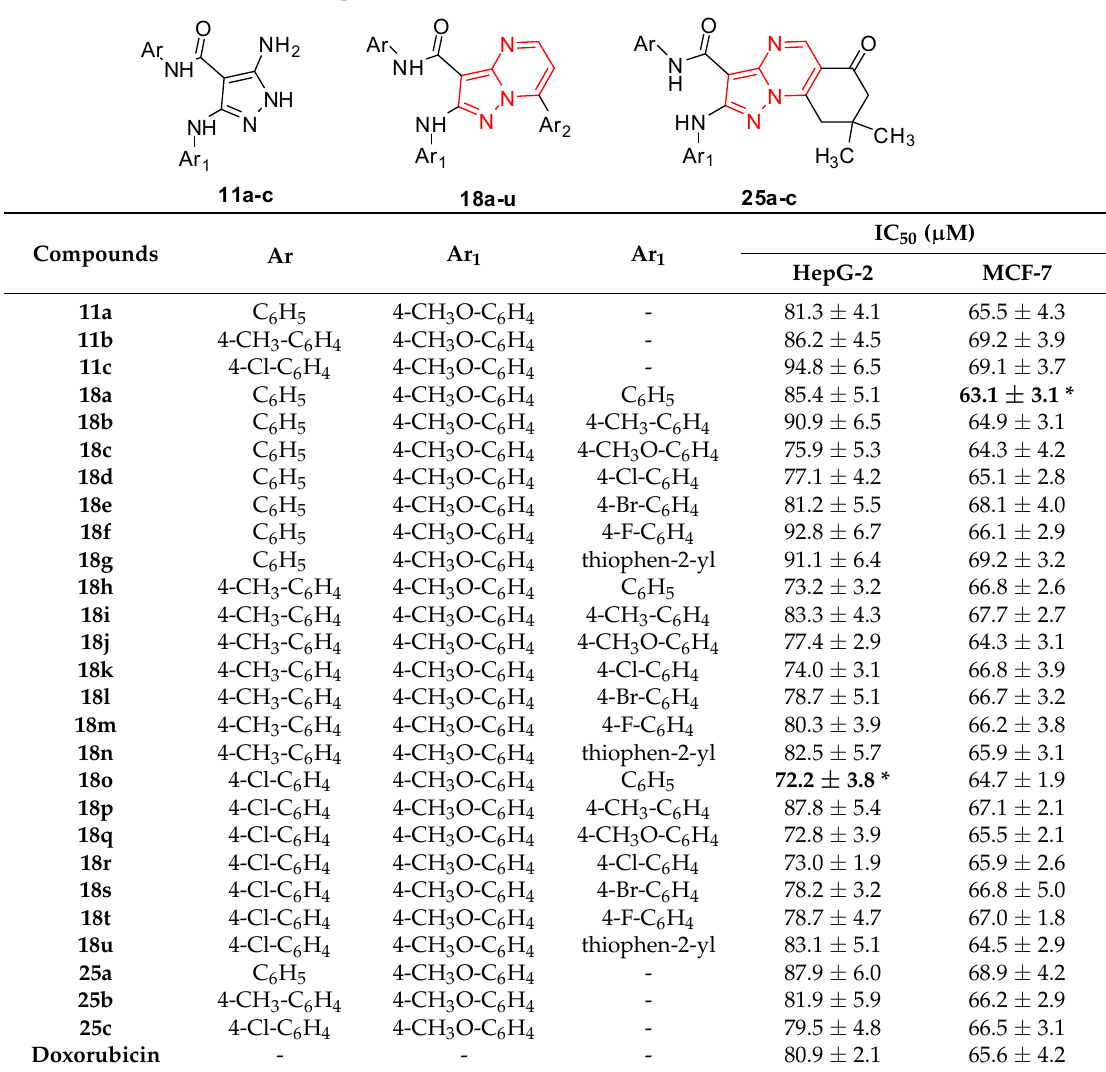
Table 1. The IC 50 (µM) values of compounds 11a – c , 18a – u and 25a – c using MTT assay against two human carcinoma cell lines (HepG-2 and MCF-7).